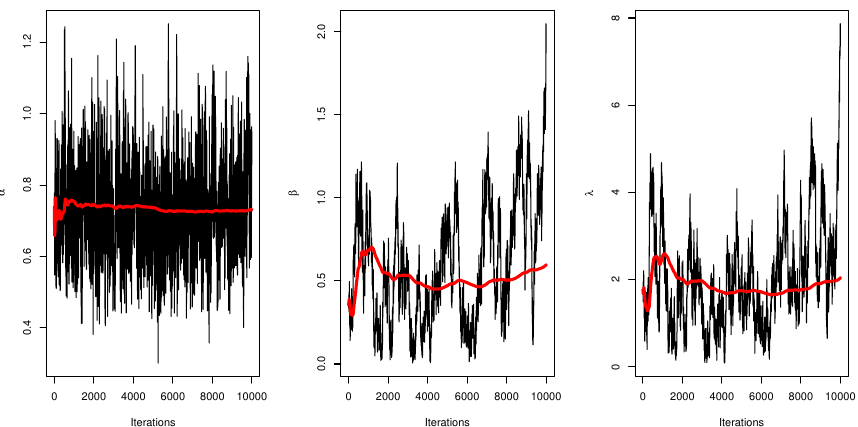
Figure 16. Trace plot of MCMC results for parameters of UEPD for the failures of 20 components data.